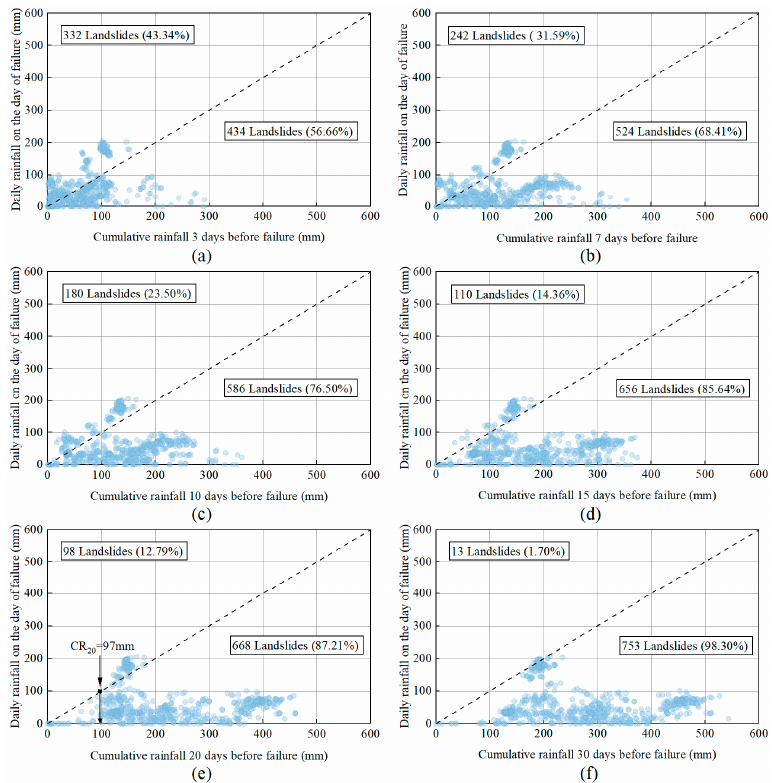
Figure 8. Plot of rainfall on the day of landslide failure versus cumulative rainfall during 3 days ( a ), 7 days ( b ), 10 days ( c ), 15 days ( d ), 20 days ( e ), and 30 days ( f ) prior to the landslide